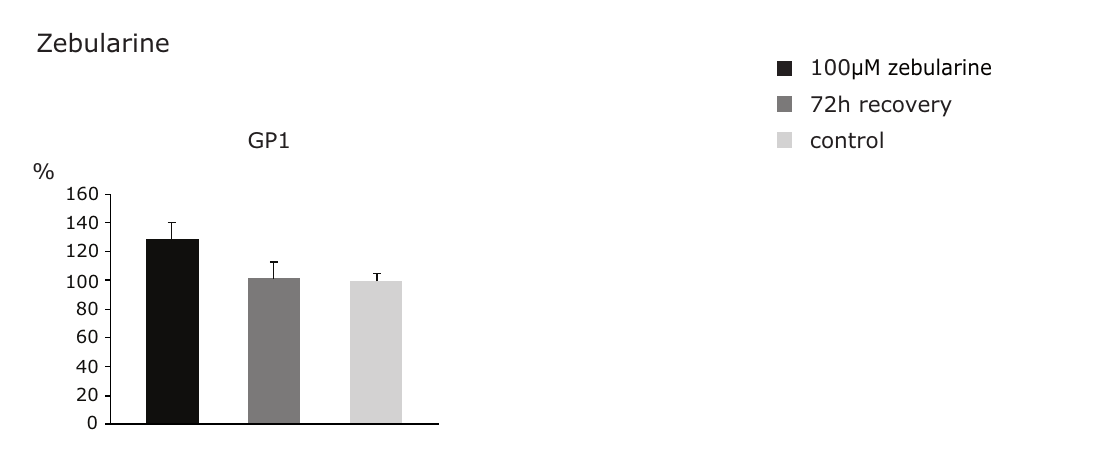
Figure 7. Changes in mean contribution of the glycan group GP1 following zebularine treatment and recovery. The observed changes were normalized to control values, which were set to 100%. The error bars represent standard deviations obtained on the basis of 4 independent experiments.